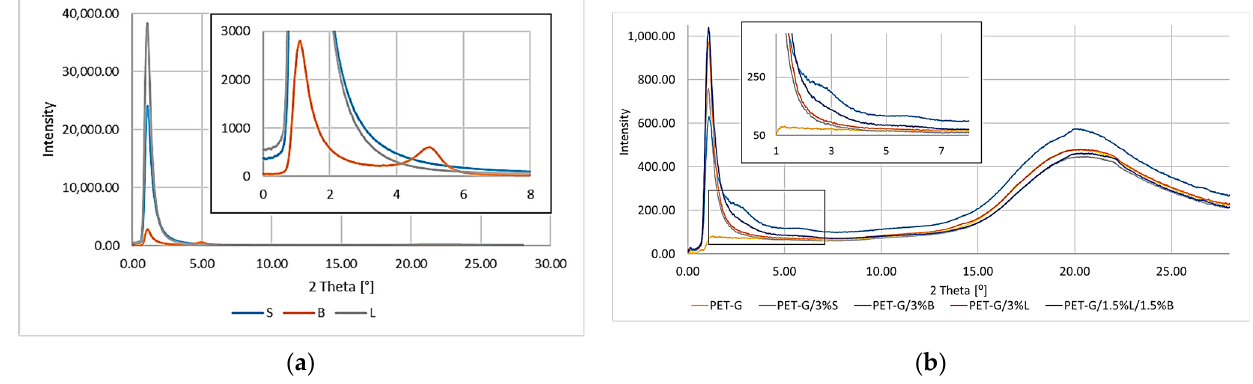
Figure 10. WAXS patterns: ( a ) fillers; ( b ) PET-G and composites with the addition of modified S, B, and L fillers.